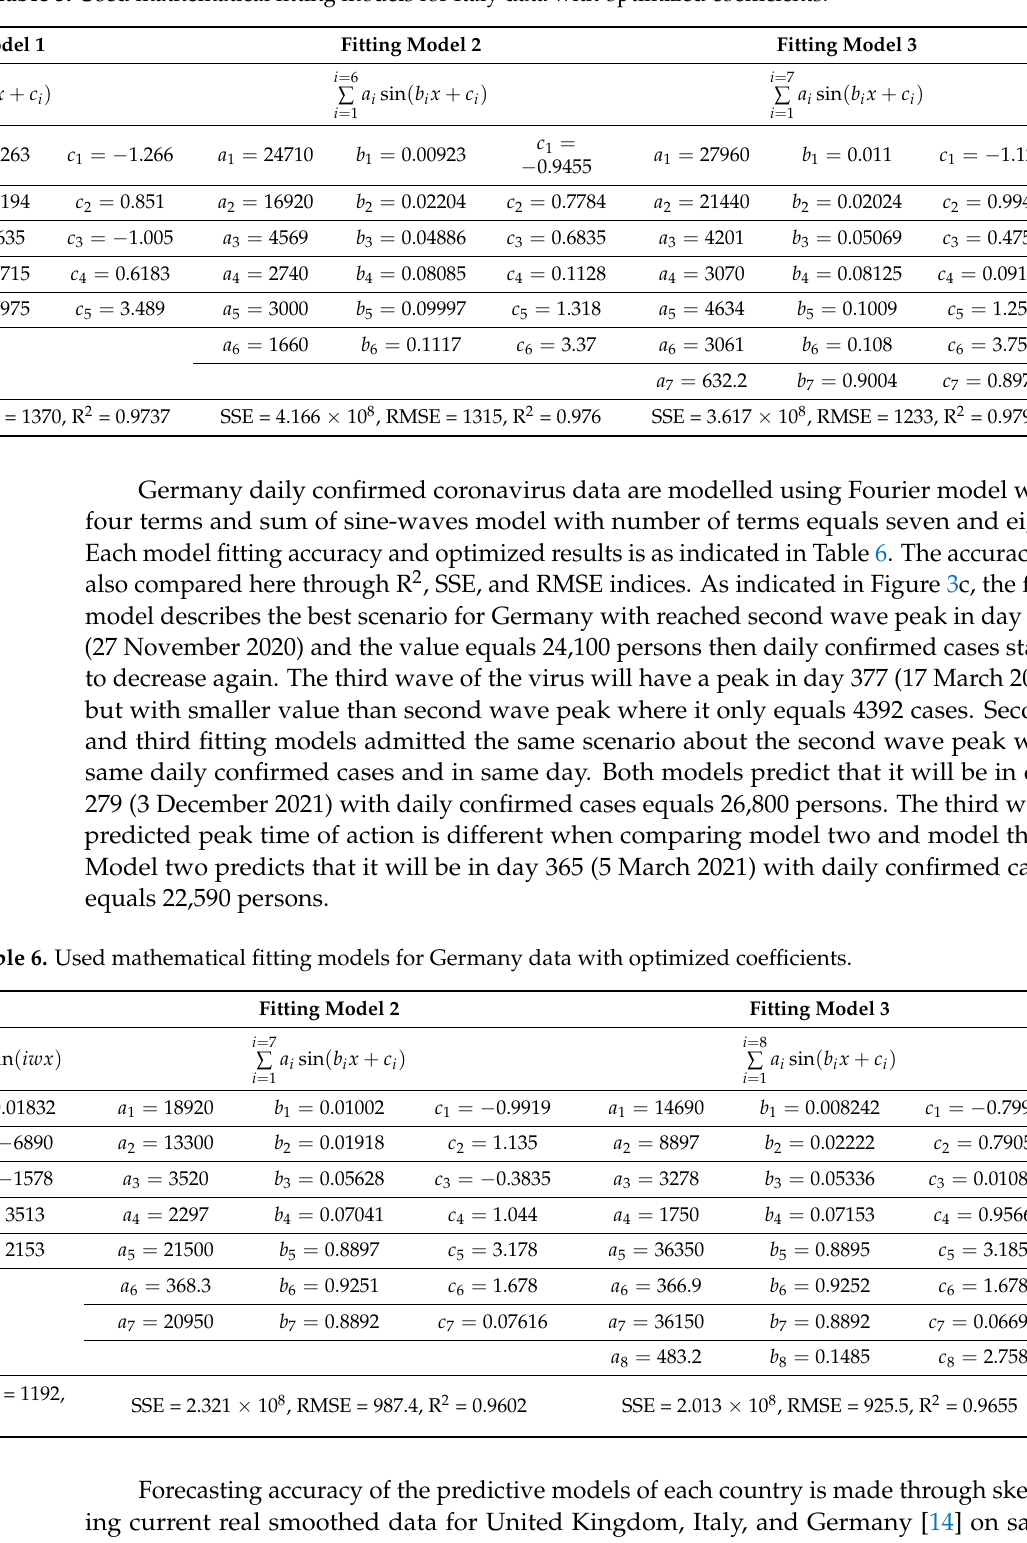
Table 5. Used mathematical fitting models for Italy data with optimized coefficients.